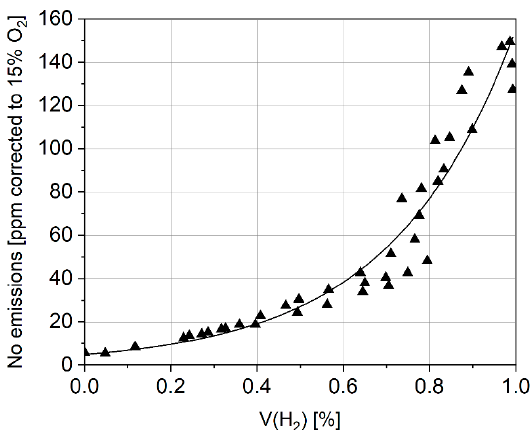
Figure 19. The relationship between the NO emissions of natural gas and hydrogen and the volume fraction of hydrogen.